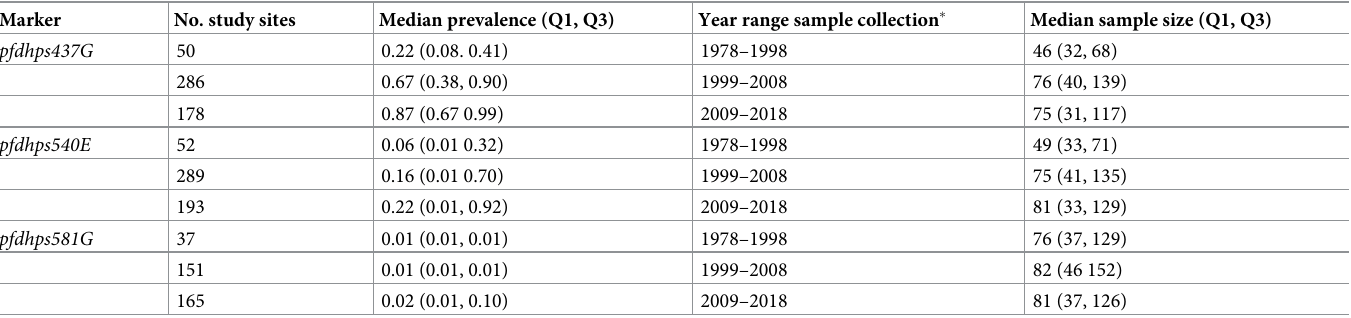
Table 2. Summary of the pfdhps marker data used in the mathematical models, by sample collection: 1978–1998, 1999–2008 and 2009–2018. Marker No. study sites Median prevalence (Q1, Q3)